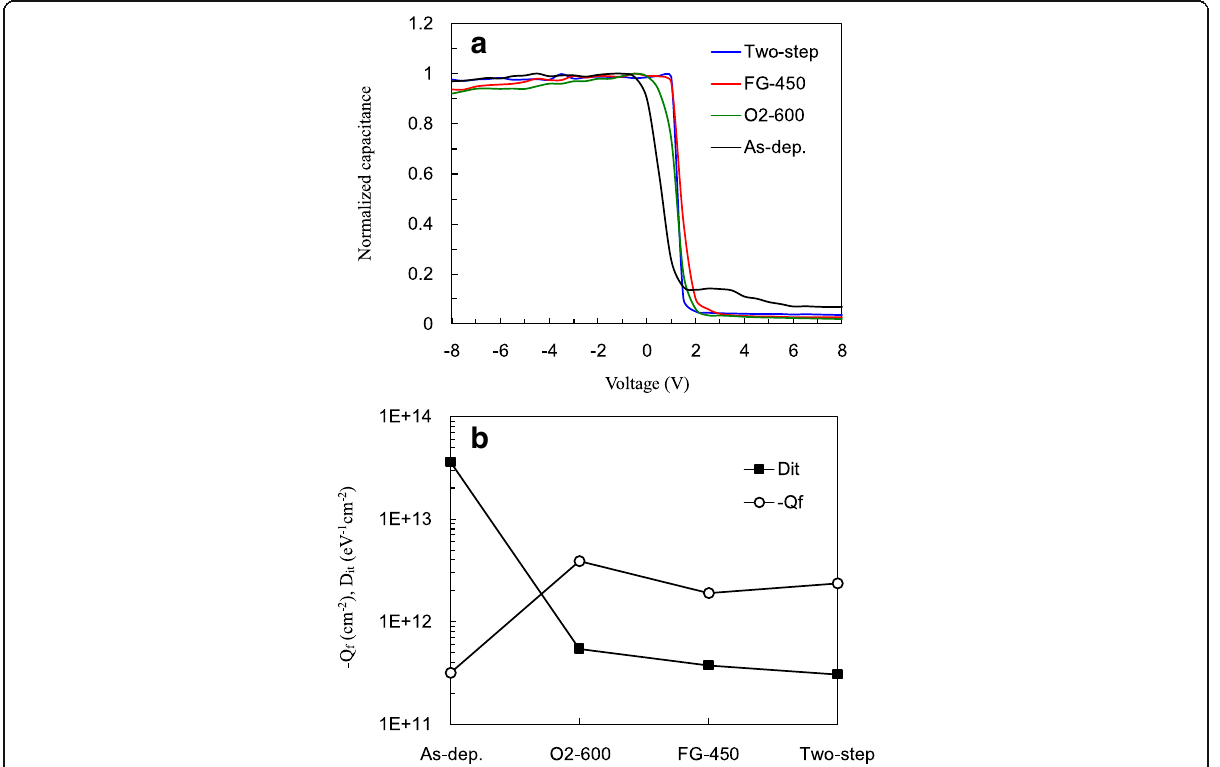
Fig. 3 a Normalized C - V curves. b D it and Q f for samples with O 2 , FG, and two-step